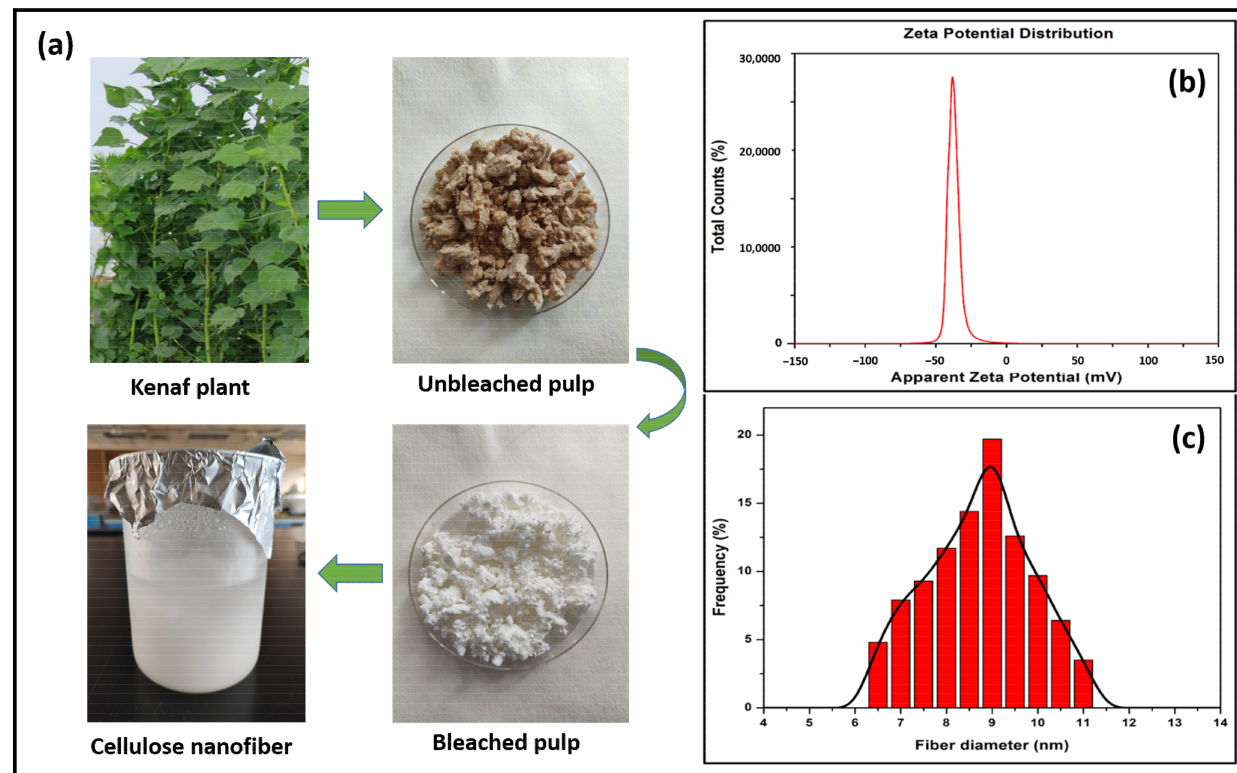
Figure 1. Material transformation ( a ), zeta potential value ( b ) and particle size distribution ( c ) of kenaf